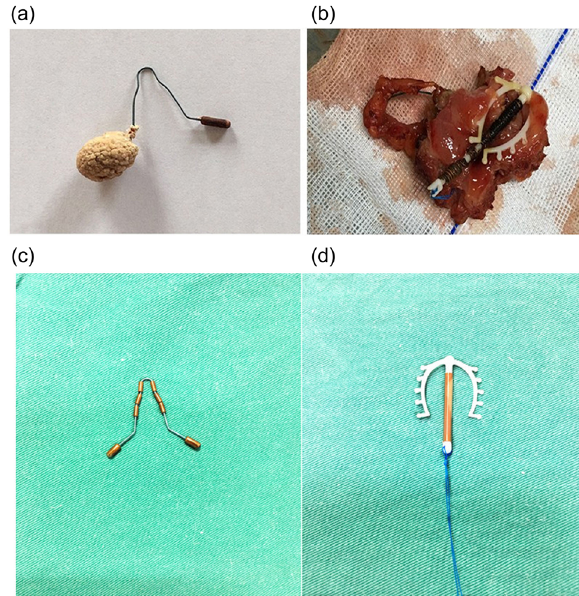
Figure 2: The IUD and associated calculus. ( a ) The IUD was an MYCu, one end of which was wrapped with the calculus. ( b ) The IUD was embedded in the bladder wall. ( c ) Normal appearance of the MYCu IUD. ( d ) Normal appearance of the Multiload Cu IUD.